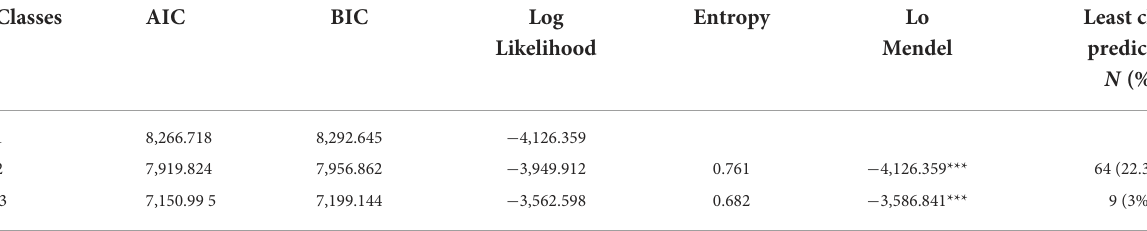
TABLE 2 Fit indices for latent class trajectory models for NKDs’ depressive symptoms.